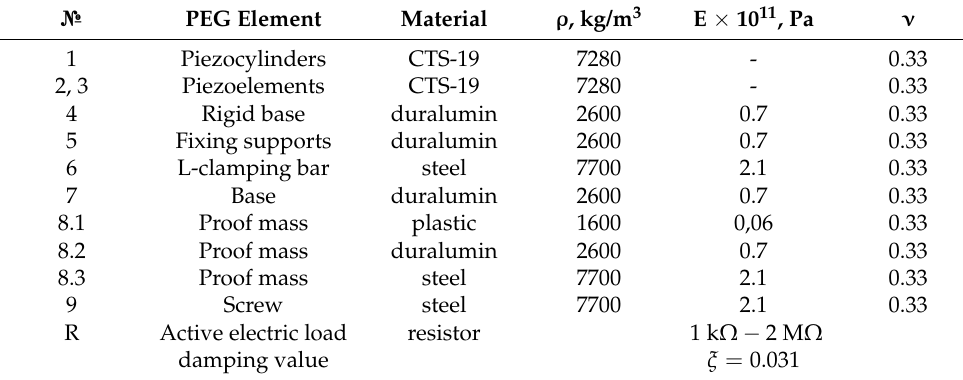
Table 2. Mechanical properties of the materials.